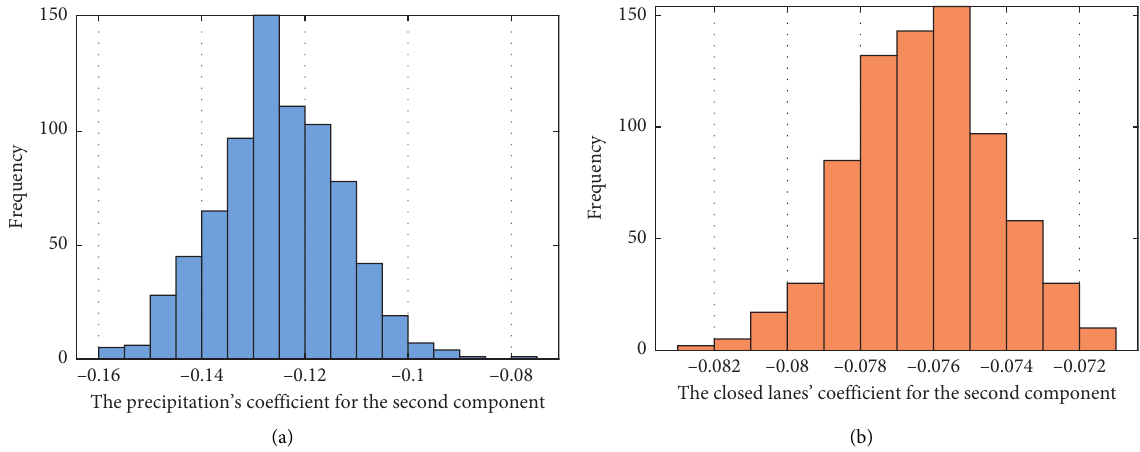
Figure 9: Histogram of the precipitation (a) and closed lanes ratio (b) coefficient for the second component (free-flow